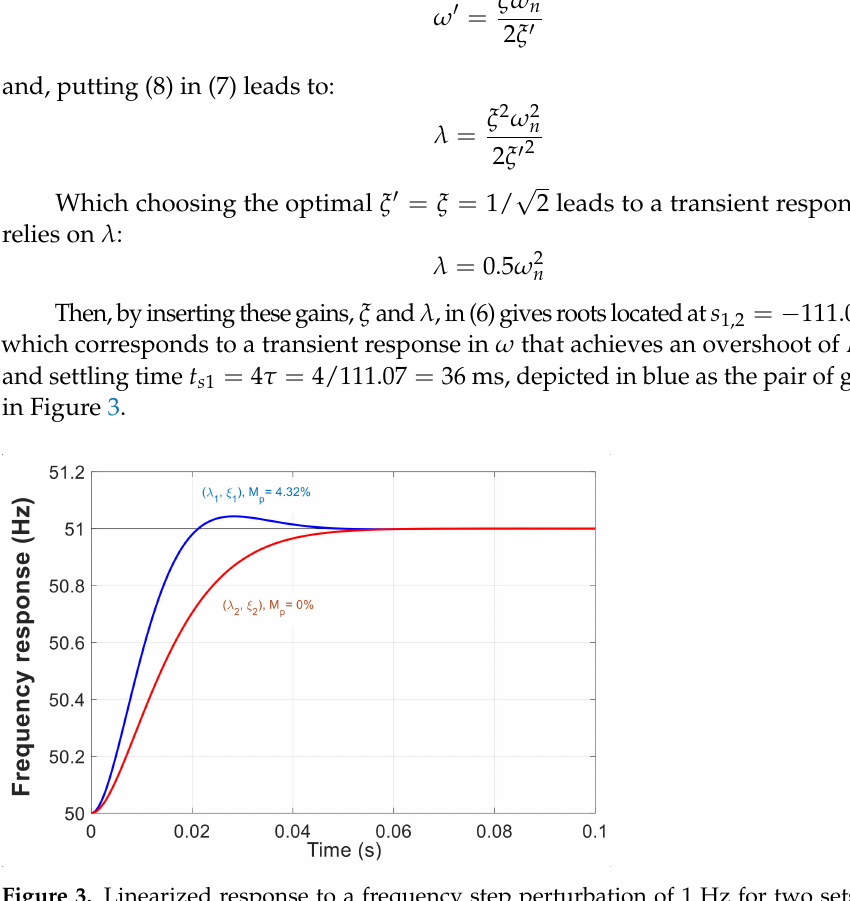
Figure 3. Linearized response to a frequency step perturbation of 1 Hz for two sets parameters: ( ξ 1 = 0.707, λ 1 = 0.5 ω 2 n ), in blue with Mp = 4.32% and ( ξ 2 = 0.707, λ 2 = 0.25 ω 2 n ), in red with Mp =